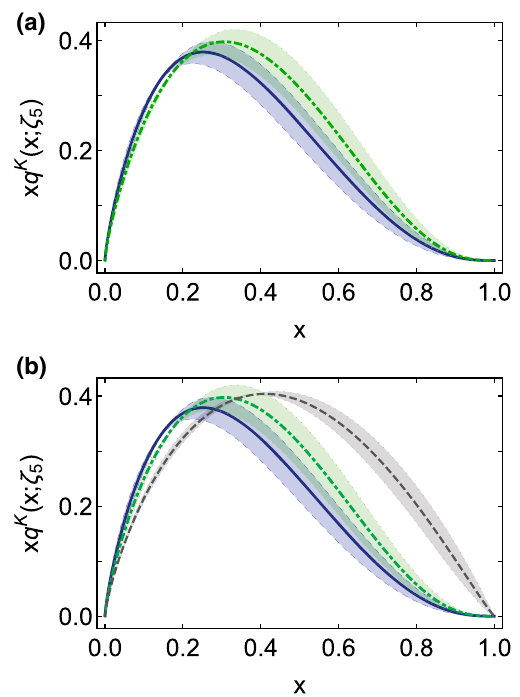
Fig. 11 a Solid blue curve – kaon’s valence u -quark distribution, defined at ζ H by Eq.(47), evolved ζ H → ζ 5 using the procedure explainedinSect.4.1.Dot-dashedgreencurve–analogousresultforthe kaon’s valence ¯ s distribution. b Dashed grey curve within grey bands – kaon ¯ s valence-quark distribution obtained in a recent lQCD study [120]; otherwise, as in A. (In both panels, the bands bracketing our central DF curves reflect the uncertainty in ˆ α( 0 ) ,